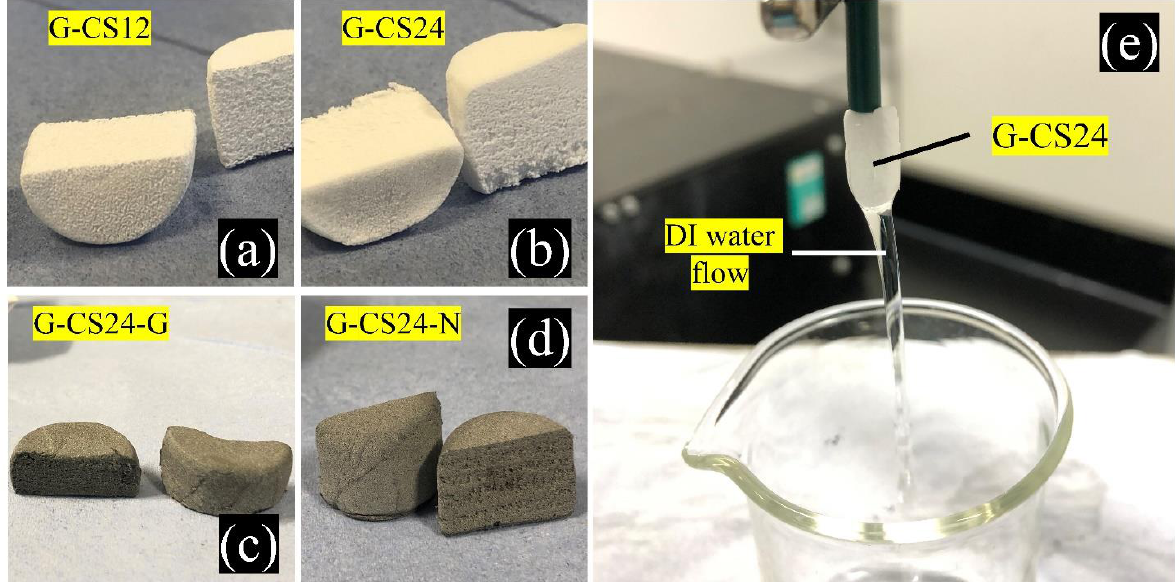
Figure 3. The appearance of the PCL/CS porous monoliths: ( a ) G-CS12; ( b ) G-CS24; ( c ) G-CS24-G; ( d ) G-CS24-N; and ( e ) the water flushing on the G-CS24 monolith.